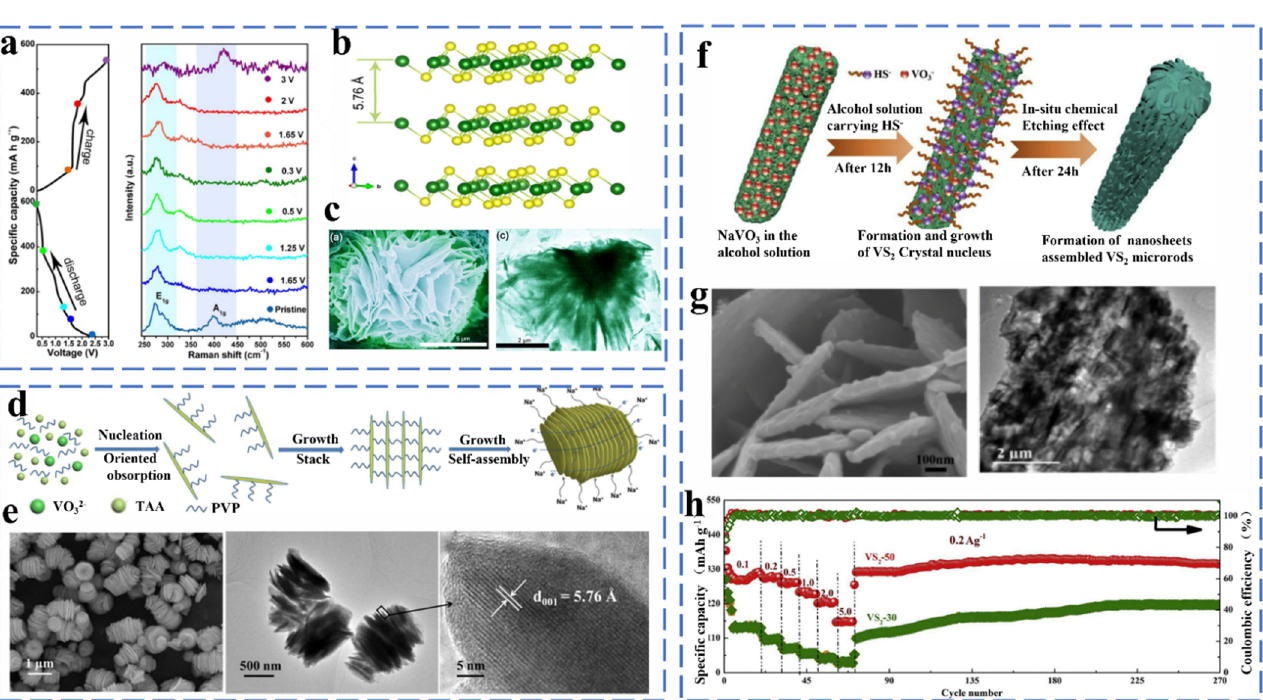
Figure 12. ( a ) The discharge–charge curves of the first cycle and ex situ Raman spectrum at different discharge–charge states, ( b ) Schematic crystal structure of VS 2 . ( c ) SEM and TEM image. Reprinted with permission from [82]. Copyright 2017 copyright Zhou, P. ( d ) Schematic illustration of the for- mation of layer-by-layer VS 2 -SNSs. ( e ) SEM image and TEM image and HRTEM image of VS 2 -SNSs. Reprinted with permission from [83]. Copyright 2018 copyright Cui, J. ( f ) Schematic illustration of the in situ chemical etching process of nanosheets assembled 3D hierarchical VS 2 microrods. ( g ) SEM and TEM image. ( h ) Rate and cycling performances. Reprinted with permission from [84]. Copy- right 2018 copyright Xue, P.